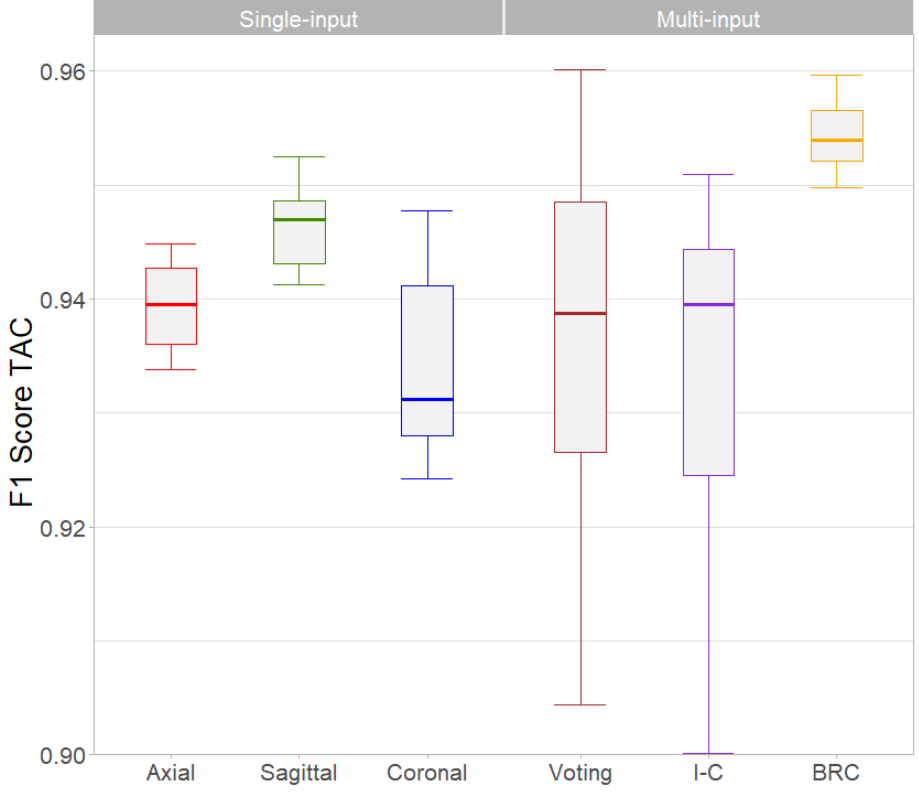
Figure 5. Boxplots of F1-Score weighted by TAC for each architecture. The BRC showed the best performance since its median value was the highest and its variance the lowest. BRC: Best Regional Combination network. I-C: Interconnected network. Table 3. For each architecture we chose the network that represented the median F1-Score value. In the test set of n = 141 patients, 90 subjects (64%) had TAC > 0. We found 1200 lesions (an average of 8.5 lesions per patient) and a cumulative TAC of 55,425 (an average of 393 per patient). Percentages of true and false positives for lesion detection and TAC were calculated with respect to 1200 and 393, respectively. The highest values in each row were highlighted in bold type. AS: Agatston Score. Axial Sagittal Coronal Voting Interconnected